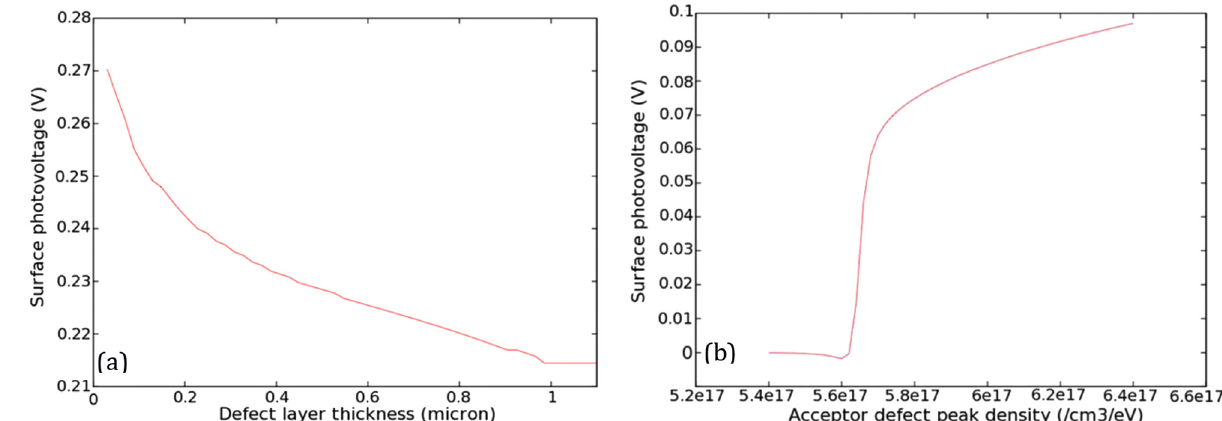
Fig. 2. Surface photovoltage simulated (785 nm illumination 1000 W/m 2 ) on bulk silicon doped n-type at N D = 10 17 cm – 3 (a) as a function of the thickness of the surface defect layer showing a reduction to a constant value for thick charge neutral layer and (b) as a function of acceptor defect density N DA (for defective layer thickness 0.1 m m) showing an initial reduction in SPV noted as a slight reduction in effective n-type doping, before N DA signi fi cantly larger than N D leads to the formation of an effective pn